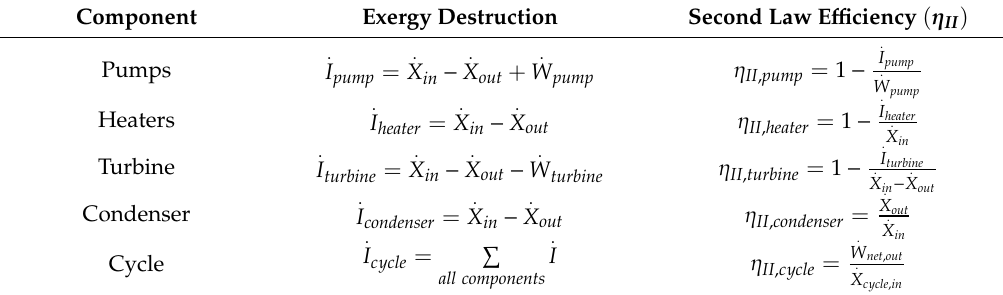
Table 2. Definitions of the exergy destruction and second law e ffi